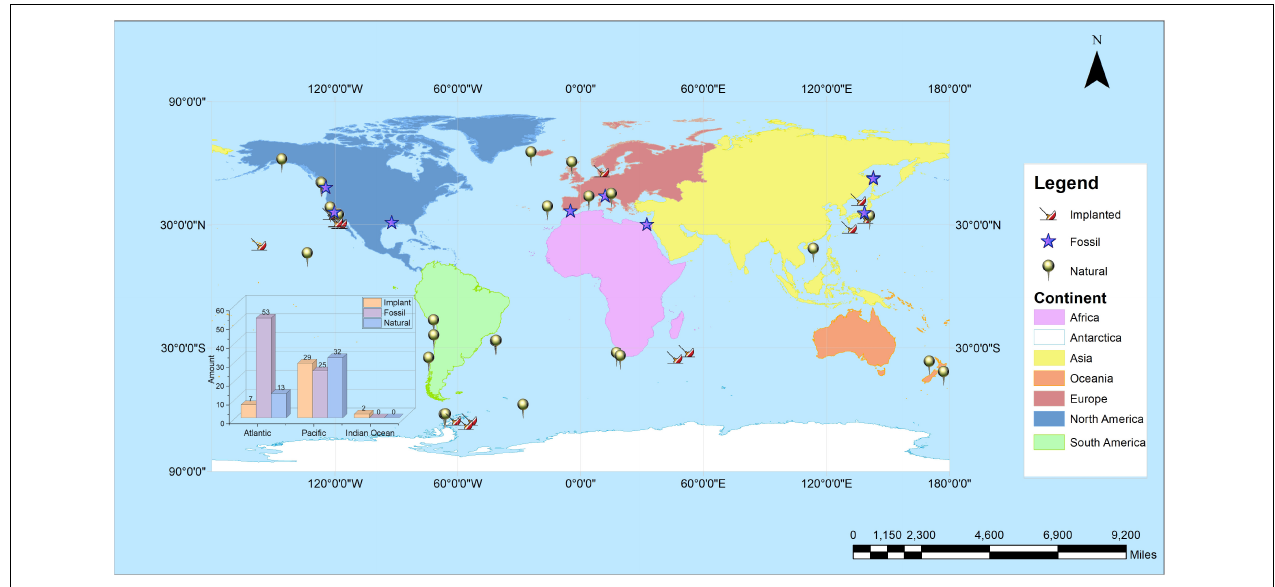
FIGURE 1 | The distribution of currently known whale falls in the